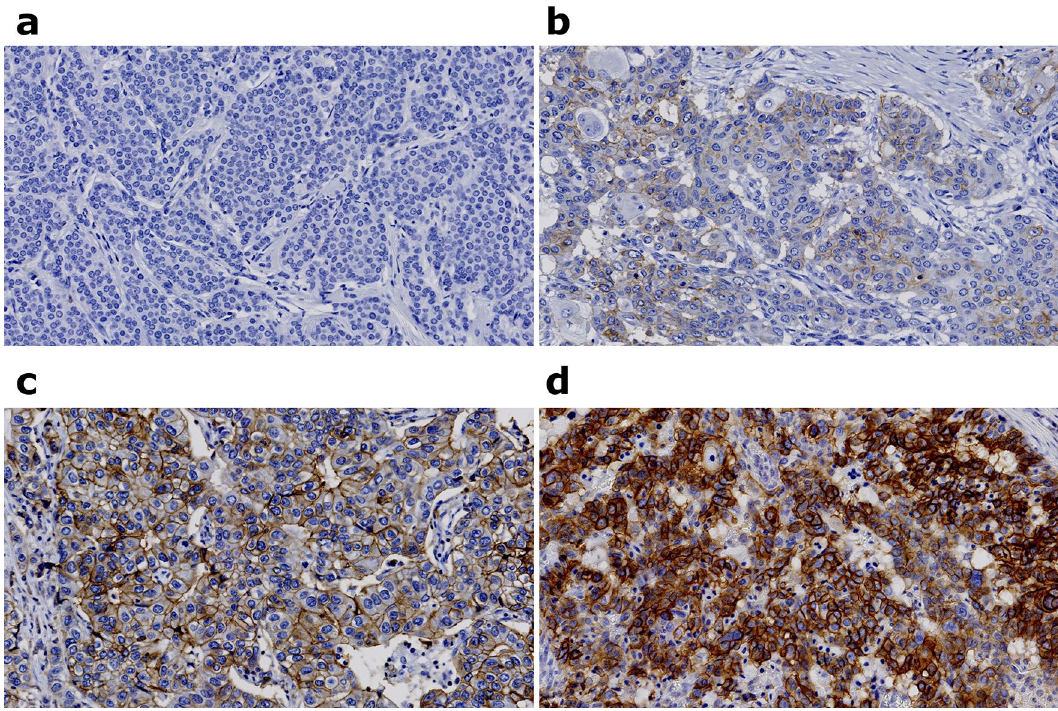
Figure 3. Immunohistochemical findings of L-type amino acid transporter 1 (LAT1) expression in breast cancer. ( a ) No staining (score 0), ( b ) weak staining (score 1), ( c ) moderate staining (score 2), and ( d ) strong staining (score 3) for LAT1 expression was detected in the cytoplasm of cancer